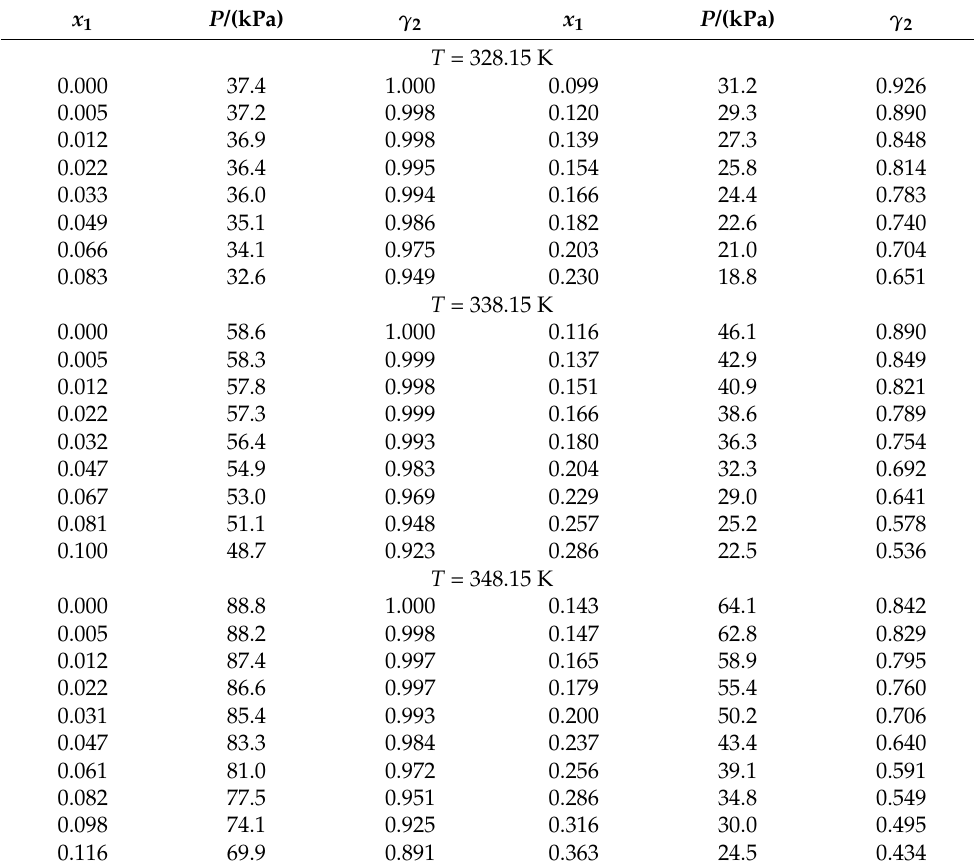
Table 2. Experimental P – T – x data for the {[C 1 C 2 MOR][DMP] (1) + Ethanol (2)} binary system: equilibrium temperature, T /K; equilibrium pressure, P /kPa, ionic liquid mole fraction, x 1 ; activity coefficient of ethanol, γ 2 a . x 1 P /(kPa)